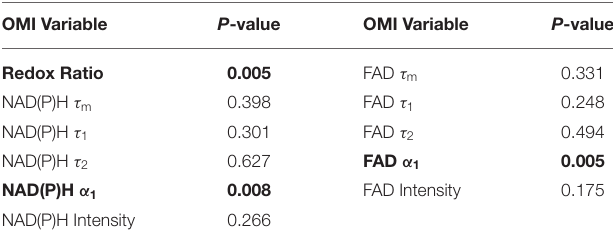
TABLE 2 | P -values from non-parametric regression between treatment condition and Moran’s I in